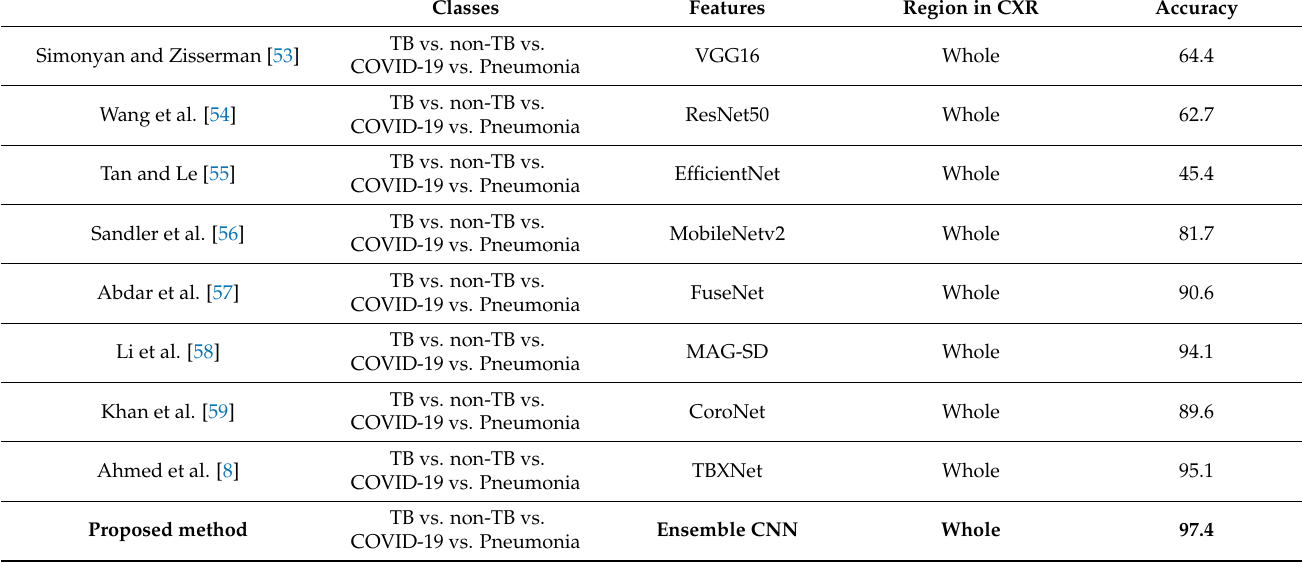
Table 7. The accuracy of the proposed methods with the existing heuristics to classify dataset